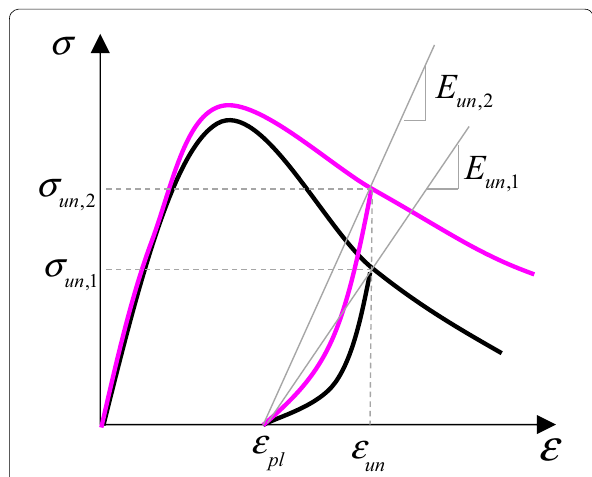
Fig. 14 Schematic of the elastic stiffness for variable concrete mixes at the same unloading